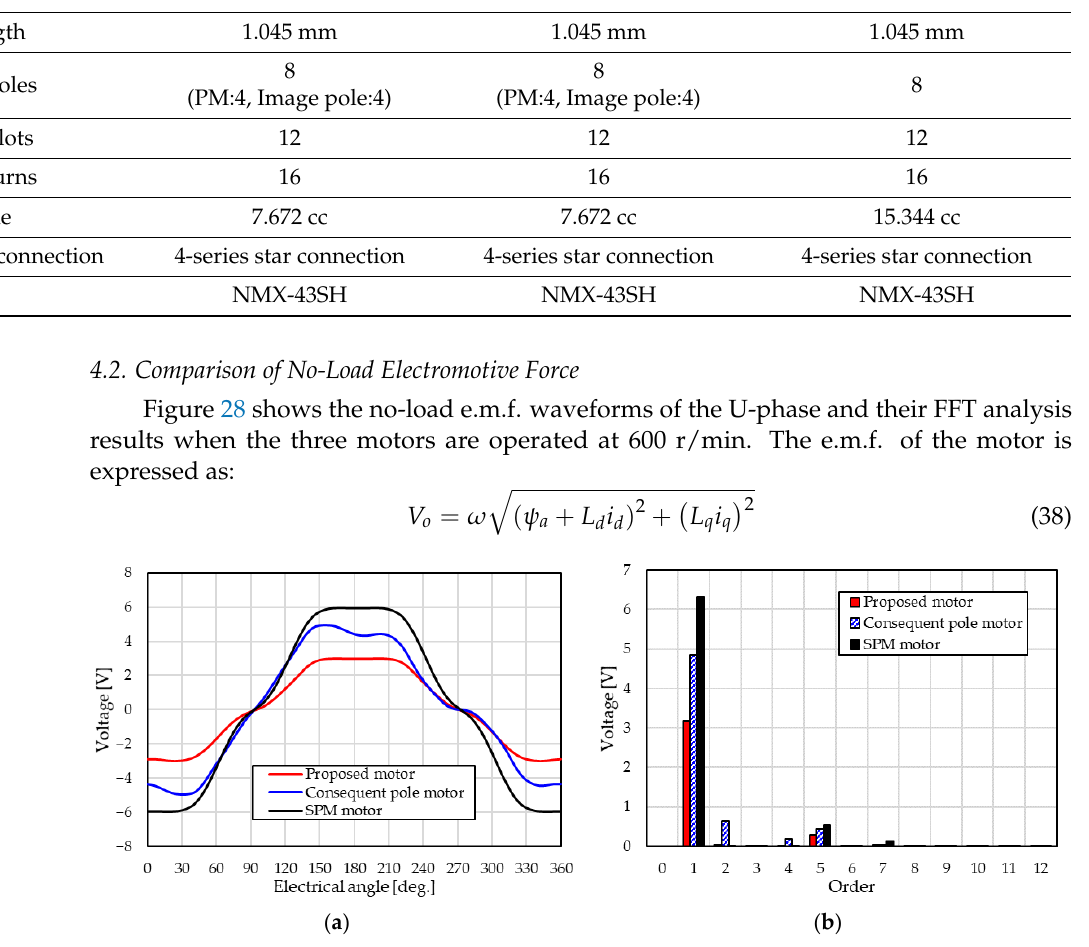
Figure 28. Comparison of back e.m.f. and FFT results: ( a ) back e.m.f. waveform; ( b ) FFT results.